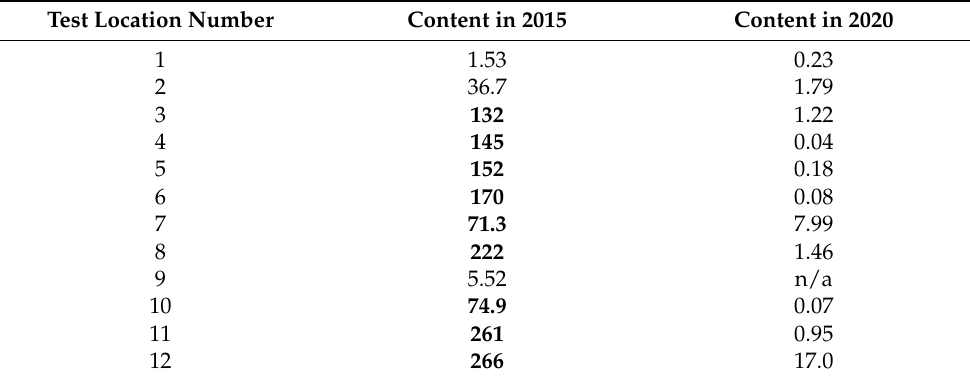
Results are expressed as the weighted average of concentration in the soil from the depth range of 0–2 m; bold font is used to mark the contents exceeding the Polish permissible soil norms; n/a—values below the detection level (0.01 mg kg − 1 DM). values below the detection level (0.01 mg kg − 1 DM).